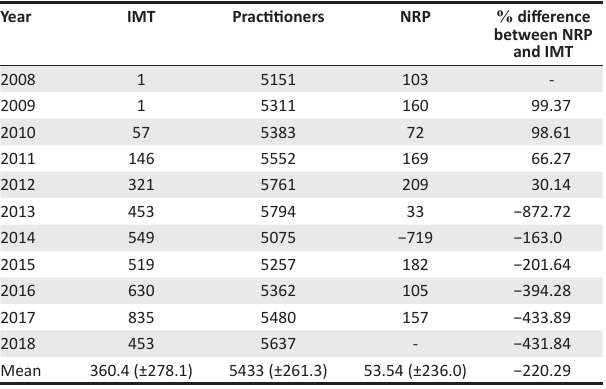
TABLE 2: The transition rate of change of South African medical technologists interns to practitioners (2008–2018).